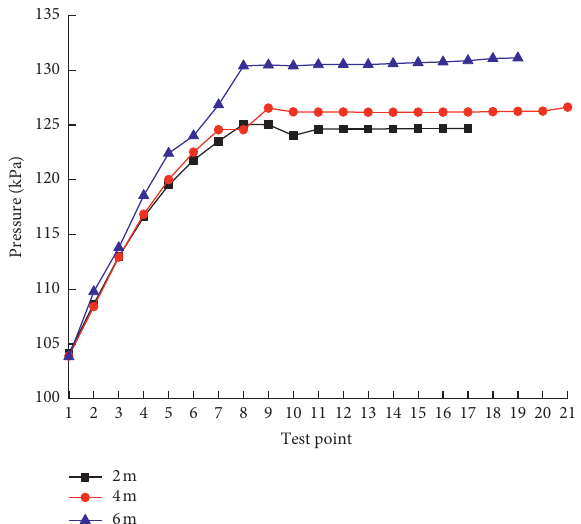
Figure 10: Curves of peak pressure under different inspection well depths.